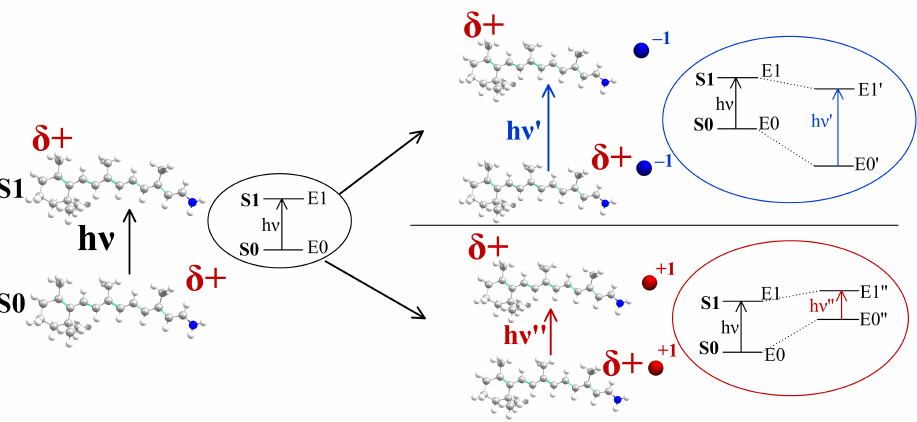
Figure 11. Difference in the charge distribution between S 0 and S 1 states of PSB leads to different electrostatic interactions of the chromophore with external